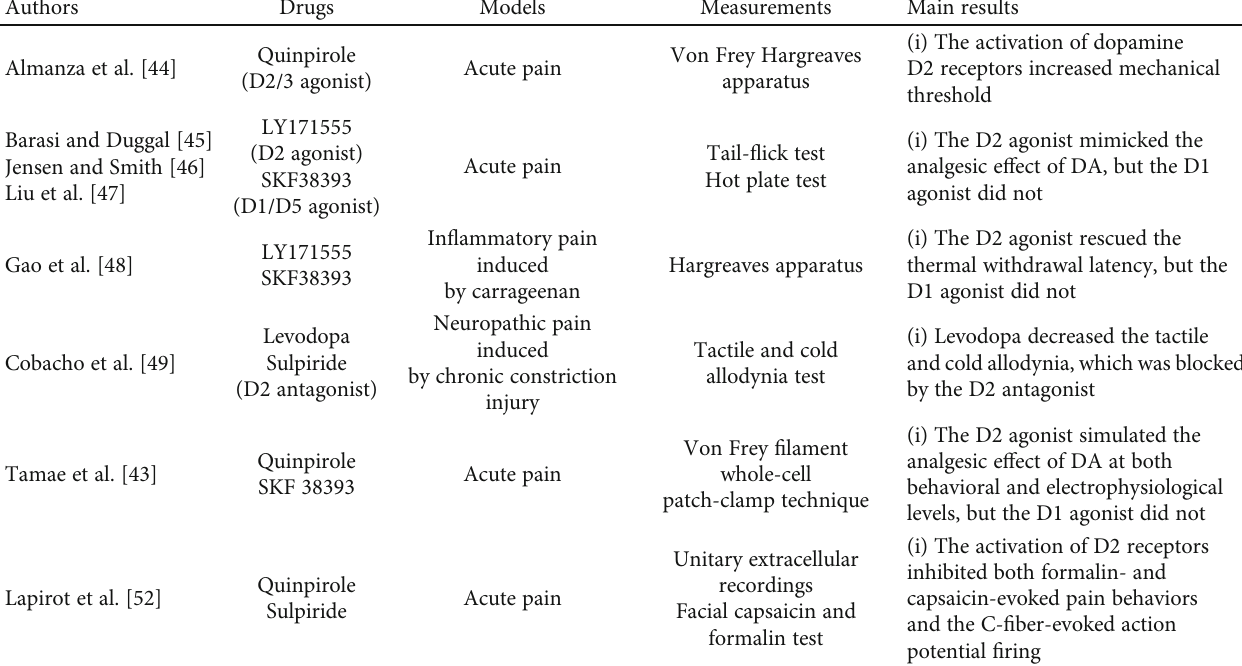
Table 1: The role of DA receptors on pain modulation in the spinal